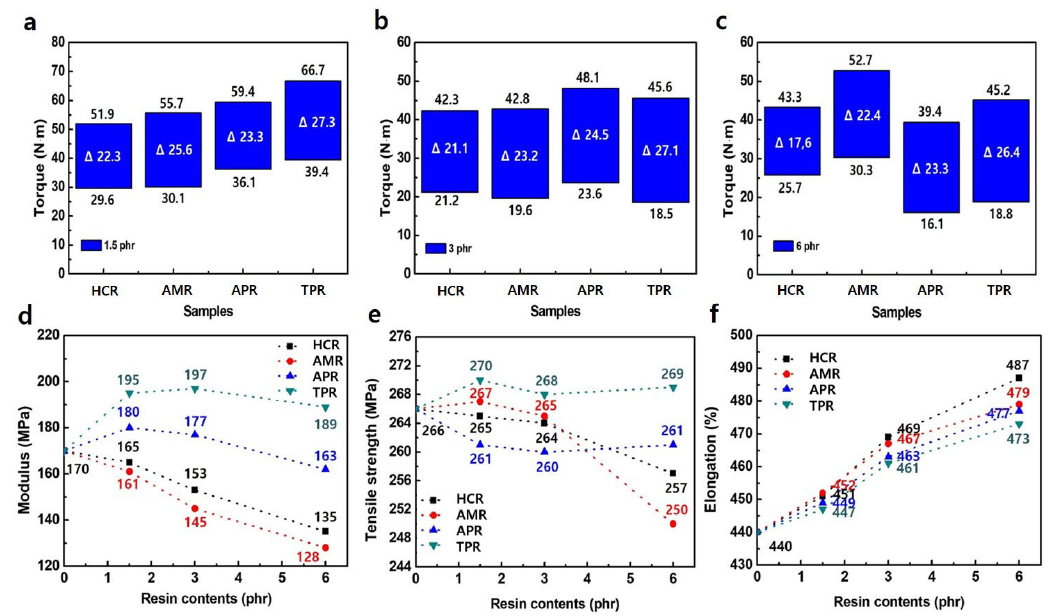
Figure 2. Curing properties of rubber composites: ( a ) curing properties (t 40 ) of the rubber composites with varying content fractions of different resins, ( b ) curing properties (t 90 ) of the rubber composites with varying content fractions of different resins, and ( c ) Mooney viscosity of the rubber composites with varying content fractions of different resins.